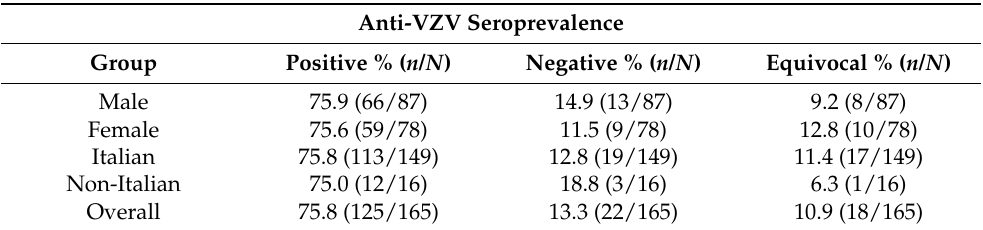
Table 1. Anti-varicella seroprevalence ( n / N : number of